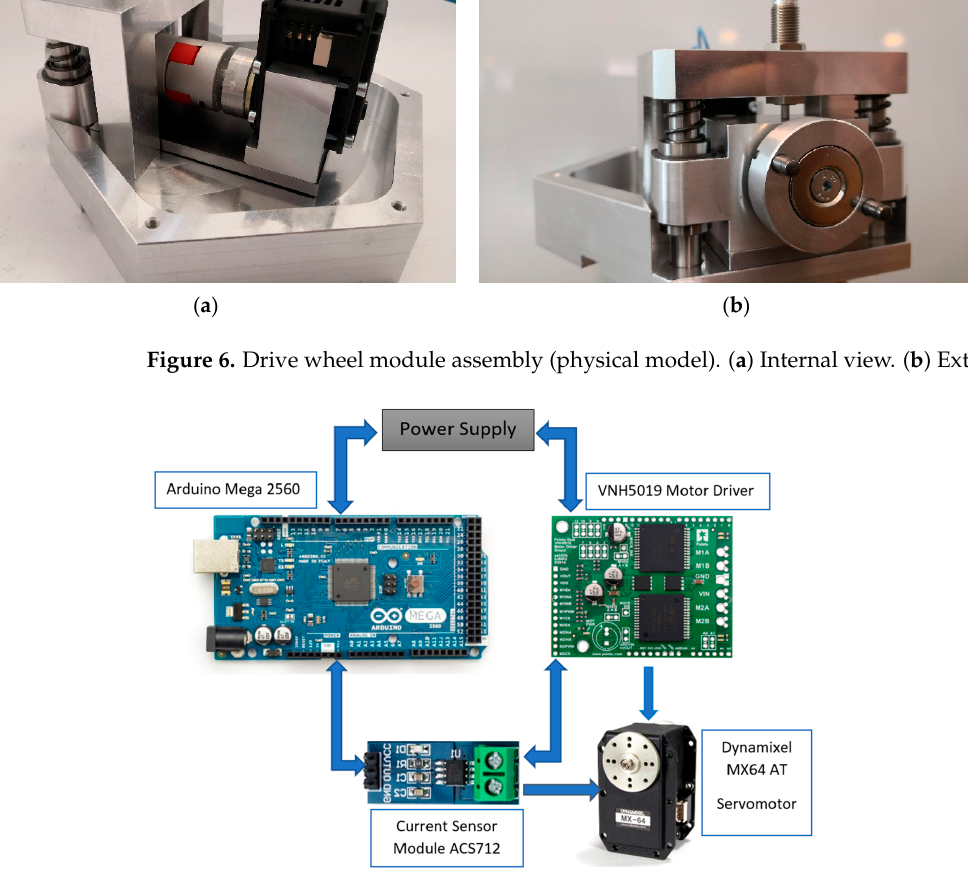
Figure 7. Block diagram of the drive wheel module electric system. Table 3. Features of the servo motor Dynamixel MX64 AT [42].